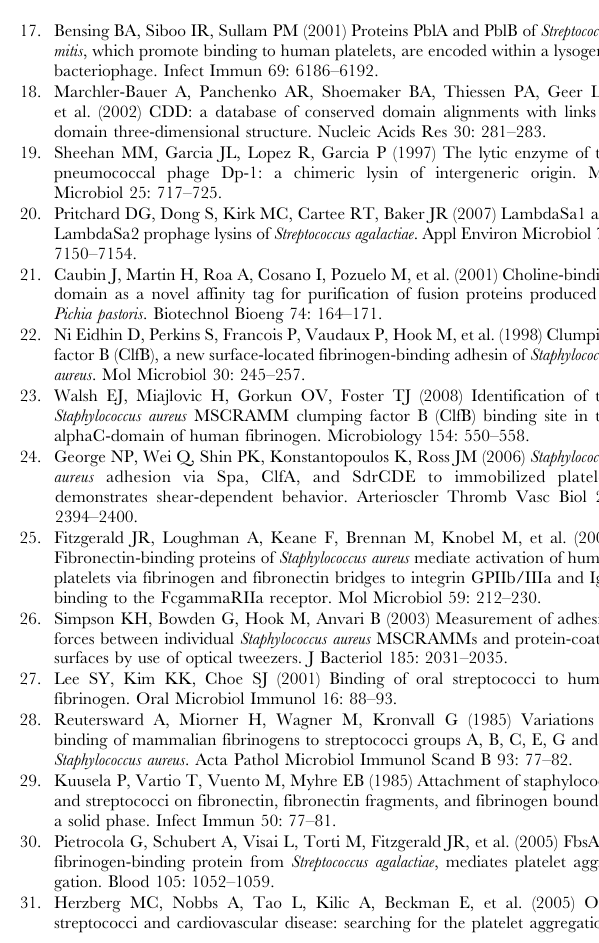
Figure S5 Structural analysis of lipoteichoic acid by MALDI- TOF mass spectrometry. A. Biochemical structure of S. mitis and S. pneumoniae LTA. B. Mass spectra of S. pneumoniae HS0001 LTA. Peaks at m/z 8572, 9872, and 11171 indicate LTA molecules with 6, 7, and 8 repeating units. C. Mass spectra of S. mitis SF100 LTA. Peaks at m/z 7273, 8573, and 9872 indicate LTA molecules with 6, 7, and 8 repeating units. Due to composition of lipid tails, each peak has at least three satellite peaks that differ from the major peak by 26–28 AMU.